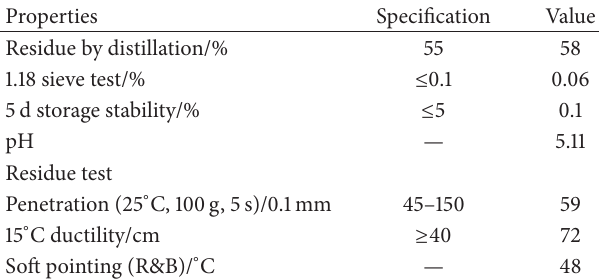
Table 2: Test results of cationic asphalt emulsion.